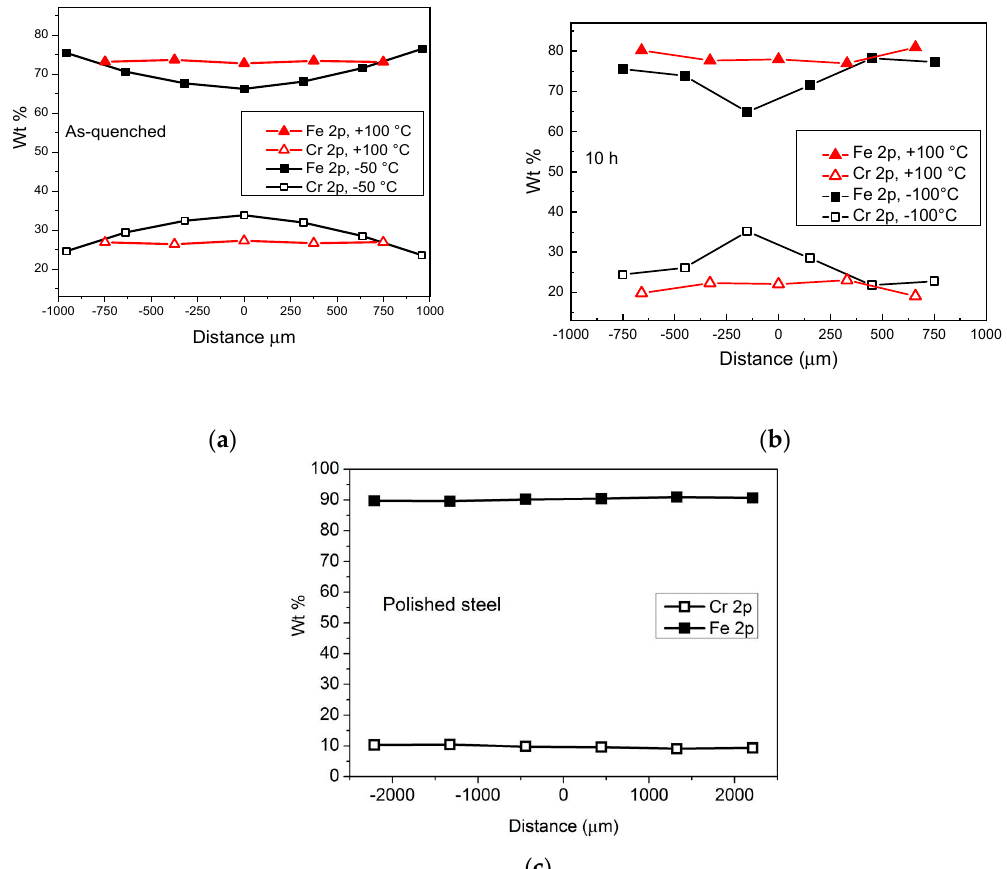
Figure 9. Small-area XPS line scans across the fracture surfaces of probes broken in brittle and ductile fields: ( a ) as-quenched and ( b ) treated at 700 °C for 10 h. The indicated distance is taken from the fracture centre. For comparison, the scan of the cross-section of an as-quenched probe after mechanical polishing is shown in ( c ).